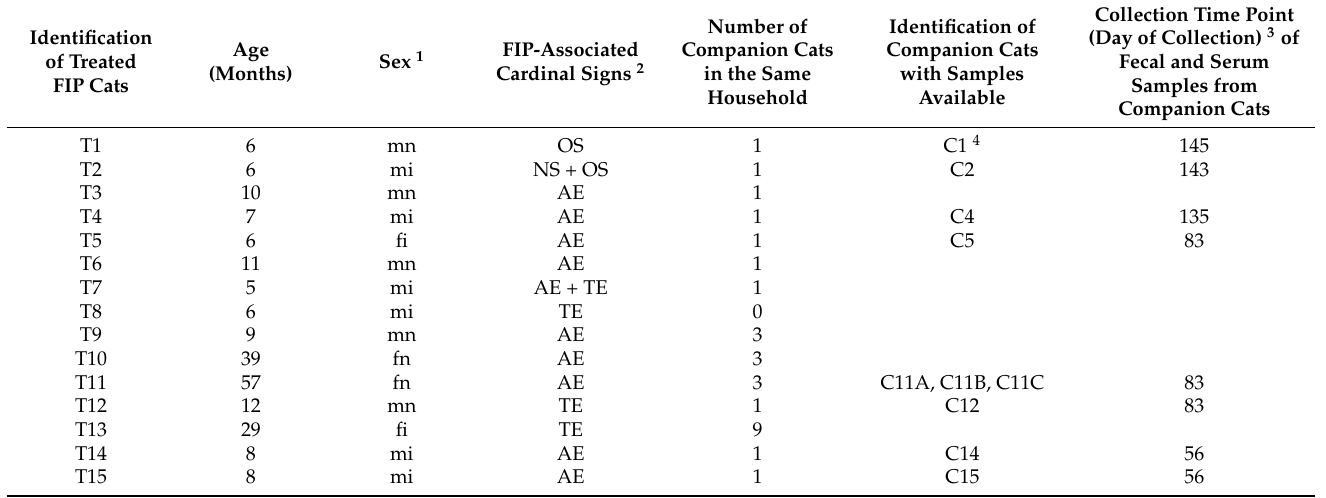
Table 1. Cats treated in the study (T1–T18), signalment, signs associated with feline infectious peritonitis (FIP), and information on companion cats in the household (C1–C18) (table partially adapted from